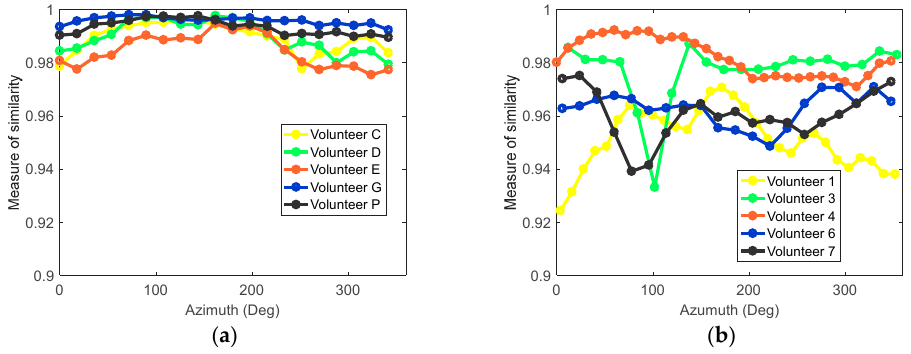
Figure 8. ( a ) Similarity measure of the skin response around the breast circumference for five different volunteers; ( b ) Similarity measure of the skin response around the breast circumference for five different volunteers from the previous prototype.